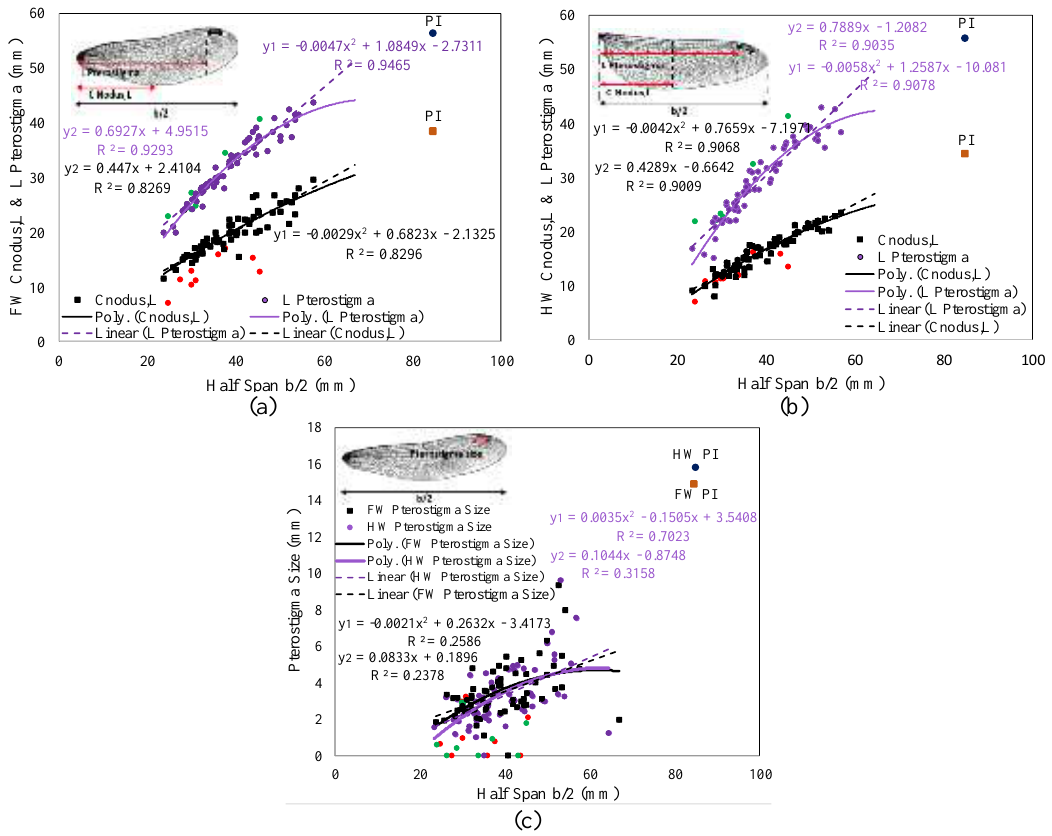
Figure 13. ( a ) Nodus chord and pterostigma location versus wing semi-span of the forewing, ( b ) nodus chord and pterostigma location versus wing semi-span of the hindwing, and ( c ) pterostigma size versus wing semi-span of the forewings and hindwings.